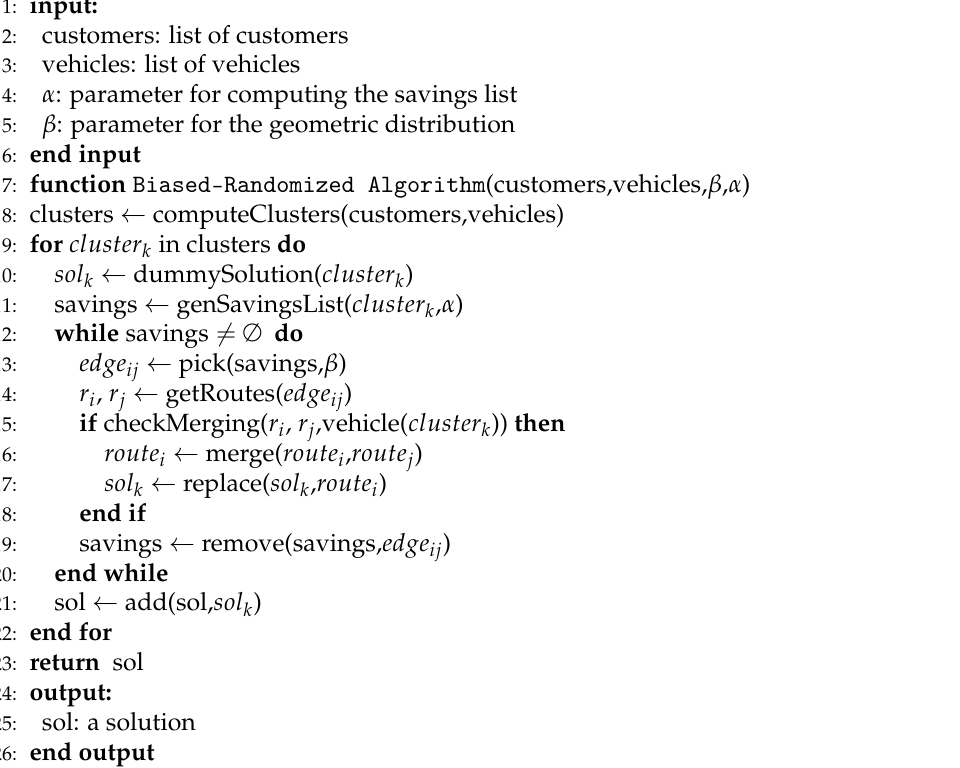
Algorithm 1 Two-stage approach algorithm for solving a static RSP